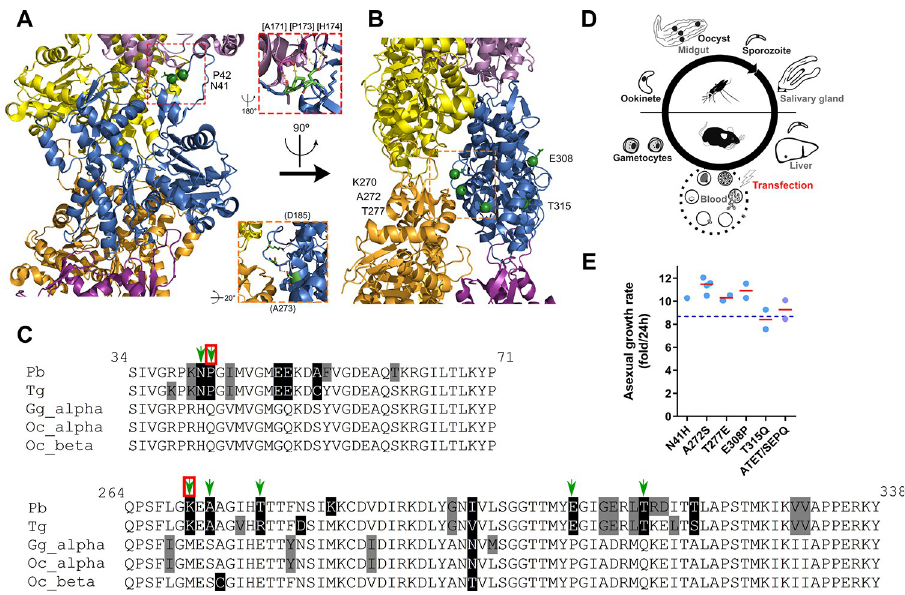
Fig 1. Plasmodium actin 1 has divergent amino acid residues in subdomains 2 and 3. (A) and (B) Plasmodium actin monomer within the filament (PDB 5OGW, P . falciparum ) [38]). The central monomer is shown in blue with neighbouring monomers in various other colours. Residues of interest are indicated as green balls. Red and orange dashed inset boxes show close-ups of relevant regions and marked residues in subdomain 2 and 3 respectively within the filament. Residues with round brackets indicate nearby intra-molecular neighbours and residues with square brackets indicate nearby inter-molecular neighbours. Thus, changes in residues of interest could have consequences for actin monomer intra- and inter-molecular contacts and/or packing. Images generated with open source PyMOL. (C) Relevant sequence sections of Plasmodium actin subdomains 2 and 3 reveal highly sequence divergent positions between apicomplexans and vertebrates. Green arrows indicate the residues of interest, red boxes indicate residues that we previously attempted unsuccessfully to mutate in the parasite [36]. Pb: Plasmodium berghei Tg: Toxoplasma gondii , Gg_alpha: Gallus gallus alpha skeletal muscle actin, Oc_alpha: Oryctolagus cuniculus aortic smooth muscle actin, Oc_beta: Oryctolagus cuniculus beta actin. (D) Schematic representation of the Plasmodium life cycle showing relevant stages. Transfection and selection of genetic modifications are performed with asexual blood stages. (E) Single asexual parasites were i.v. injected into na ï ve mice and growth rates determined. All mutants grew at rates comparable to wild- type (dashed line indicating growth rate as published previously, [36]). Red line indicates median value. Note that only one clone of mutant N41H could be